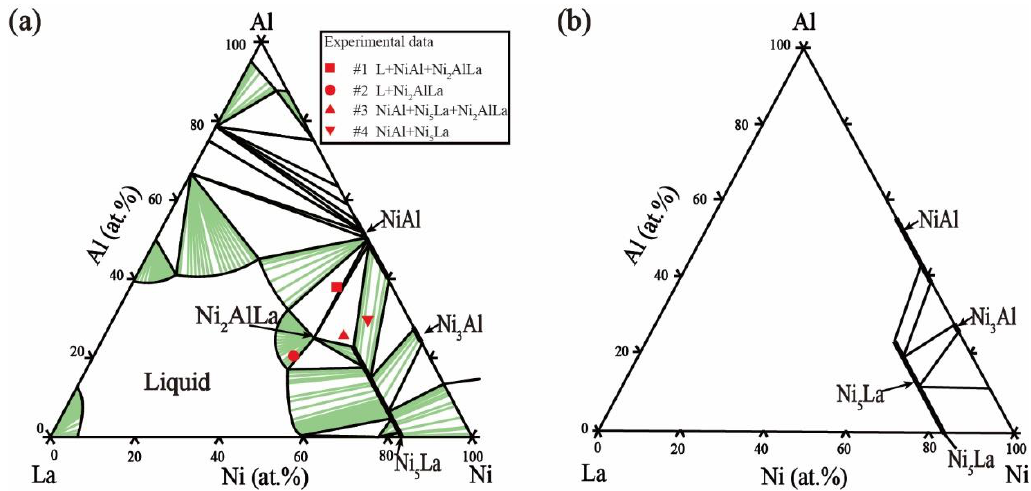
Figure 8. Isothermal section of the Ni – Al – La ternary system at 800 °C. ( a ) Our calculated isothermal section compared with our experimental results, ( b ) literature data [15].